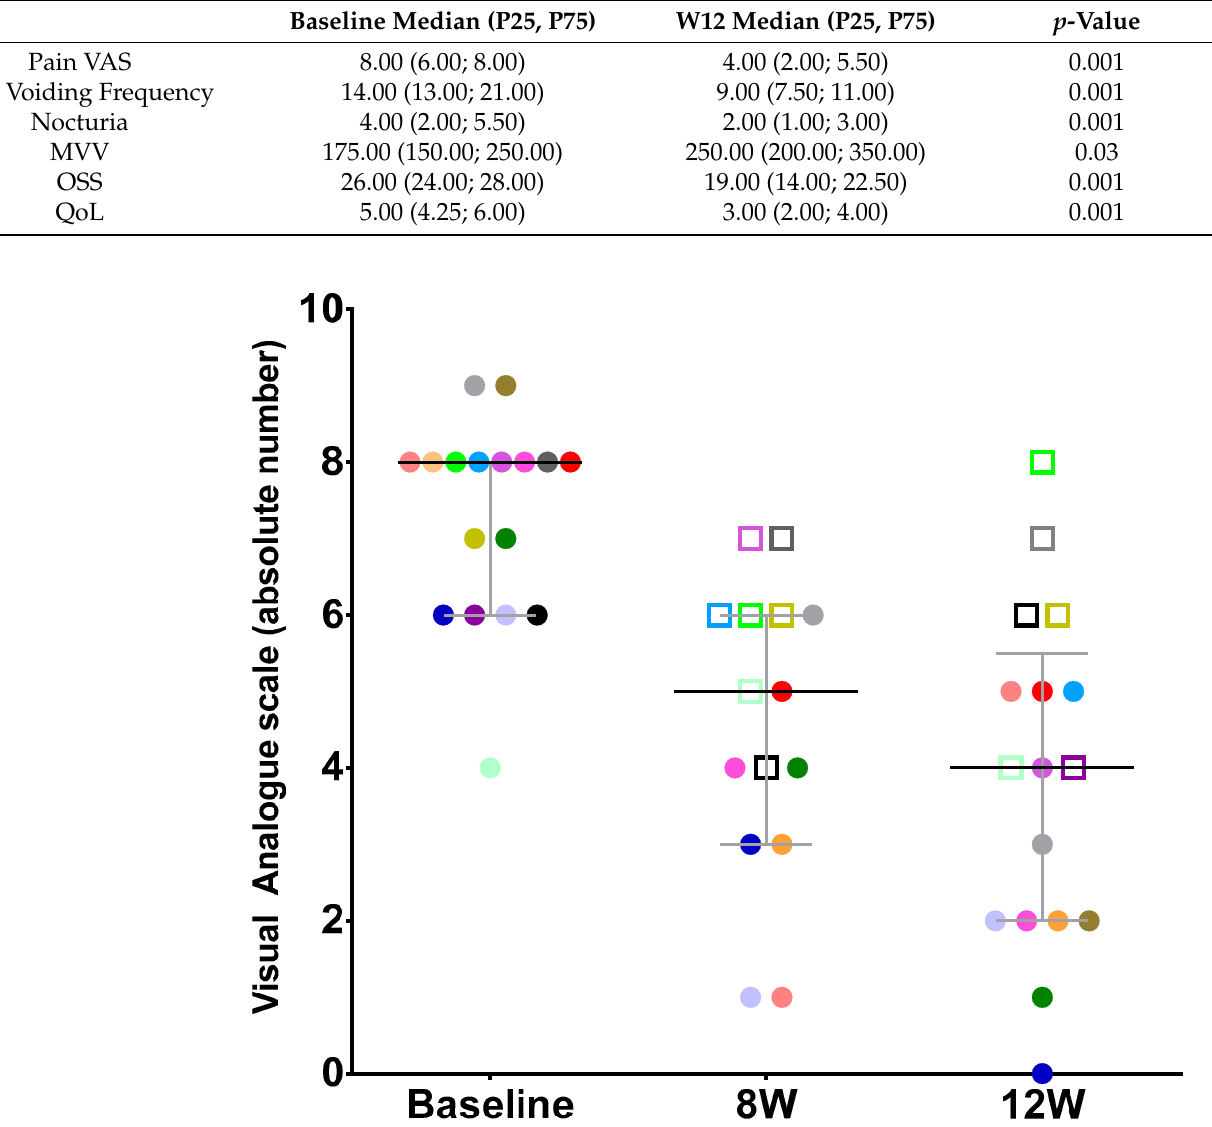
Figure 1. Median and (p25–p75) intervals and individual pain score on the VAS at baseline and weeks 8 and 12. Each patient is identified by a specific color and squares mean that MID was not reached. Table 1. Outcome comparison between baseline and 12w.